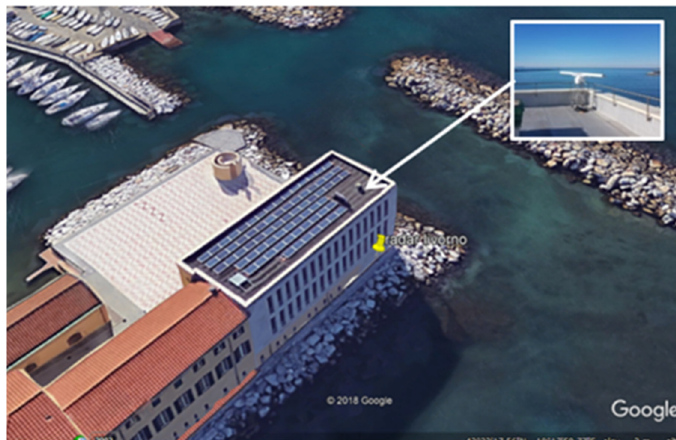
Figure 1. Photo of the Scoglio della Regina building with the detail of the radar. Table 1 summarizes the operating parameters of the radar system used for the meas- urement campaign. Table 1. Operating parameters of the radar system.